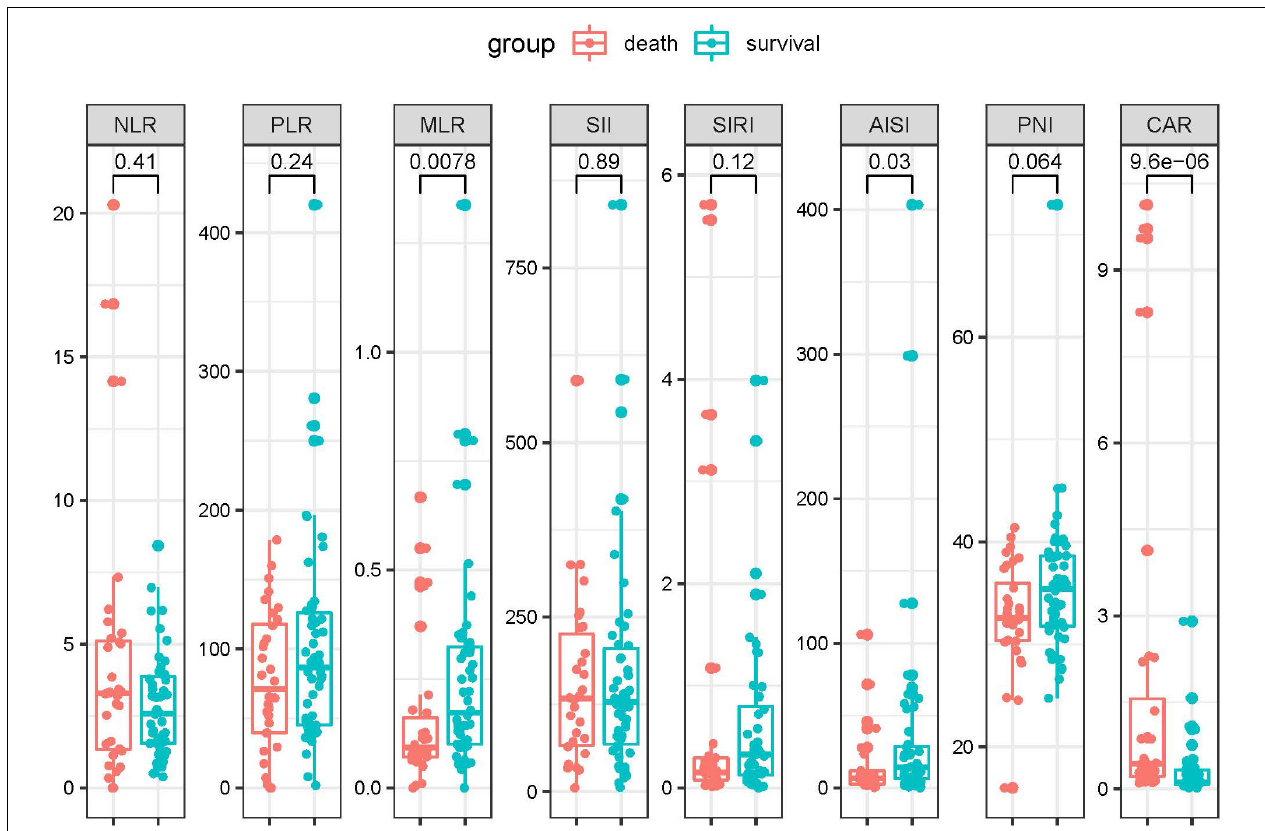
FIGURE 2 | The inflammation-based biomarkers were compared between the death patients and survival patients. Statistical significance was calculated by Mann–Whitney U test. Data are presented as median (IQR).